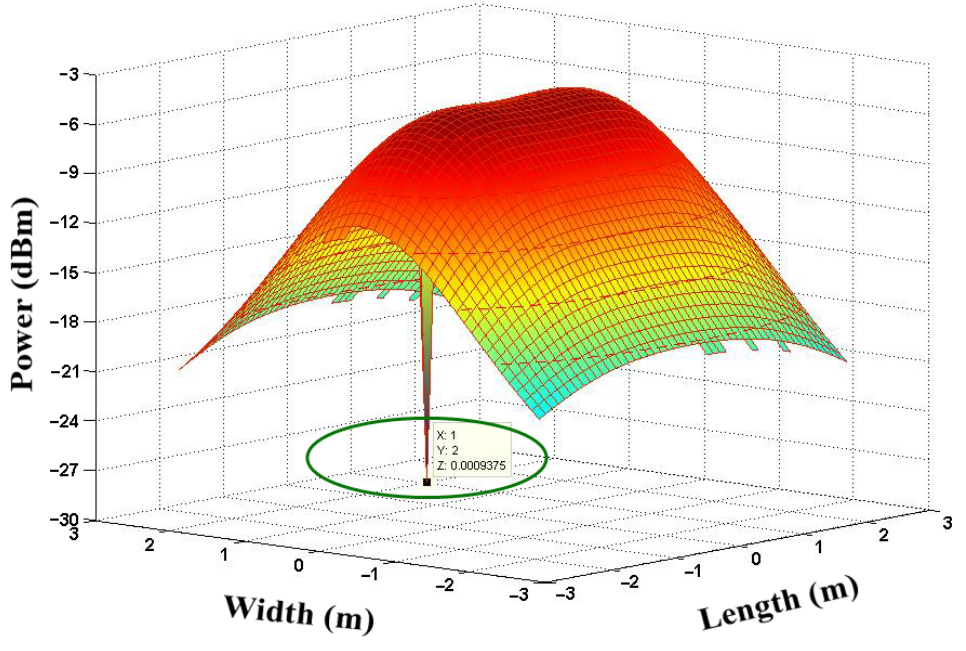
Figure 13. Allocation of the signal power received at RX Location 2, (1,2,0).